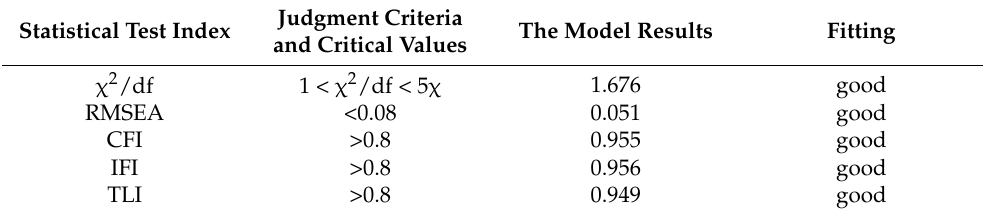
Table 4. Model fit index (N = 229).